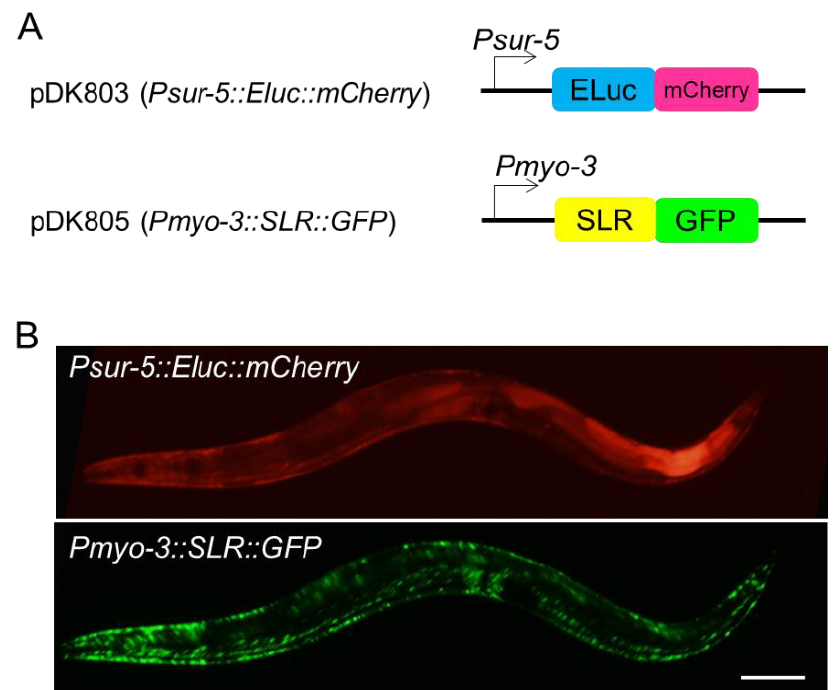
Figure 1. ( A ) Schematic representation of plasmid constructs for Eluc (Emerald Luciferase) and SLR (Stable Luciferase Red) expression. ( B ) Expression and localization patterns of Eluc (upper) and SLR (lower) fusion proteins in adult C. elegans . SLR protein tends to accumulate in body-wall muscles. Scale bar 50 μm.